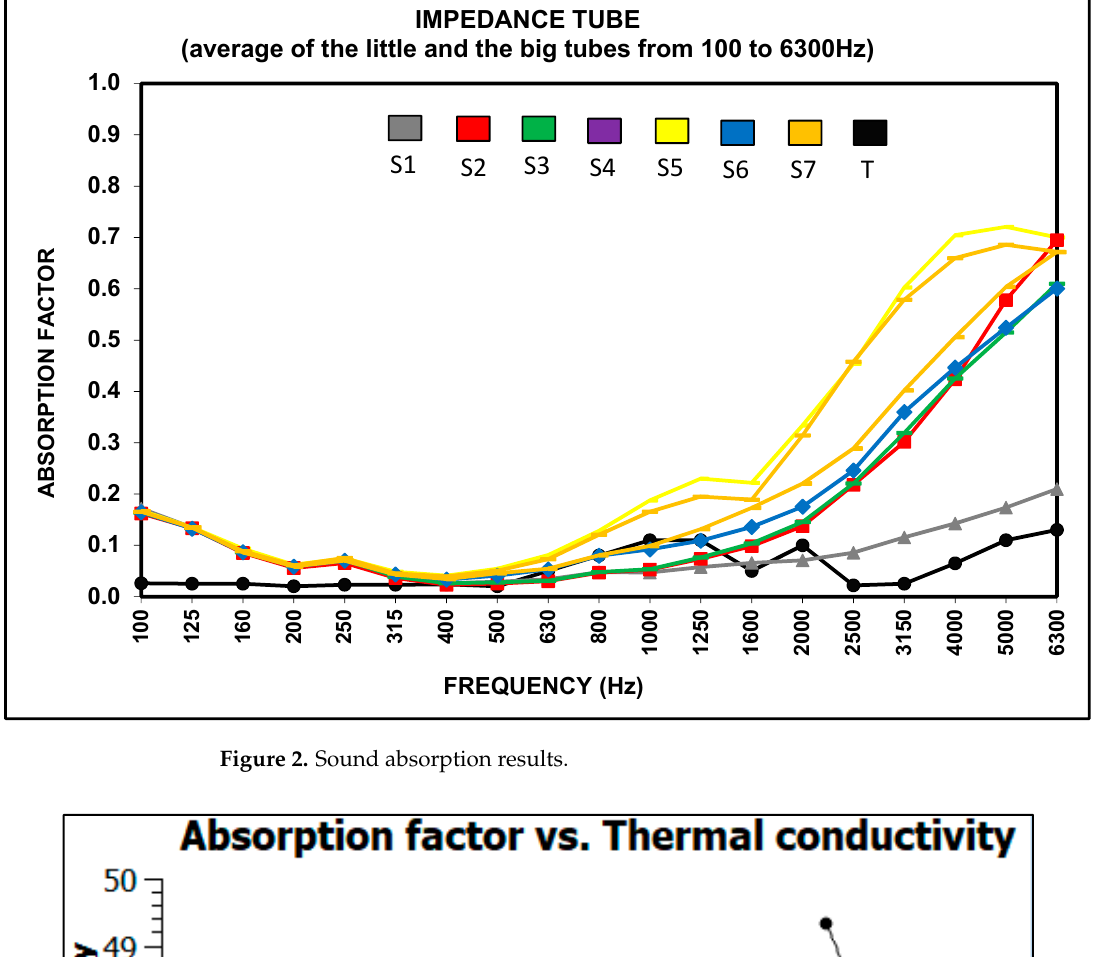
Figure 2. Sound absorption results .